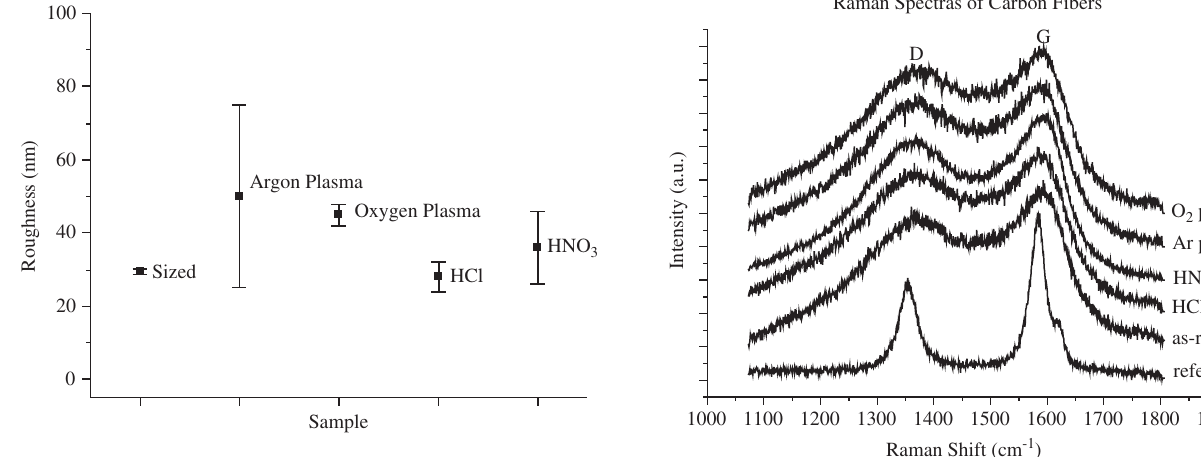
/I ratio and surface crystalline size of untreated D G